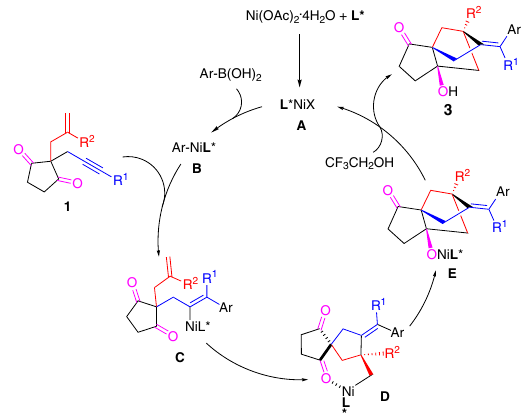
Fig. 7 Reaction mechanism. Proposed catalytic